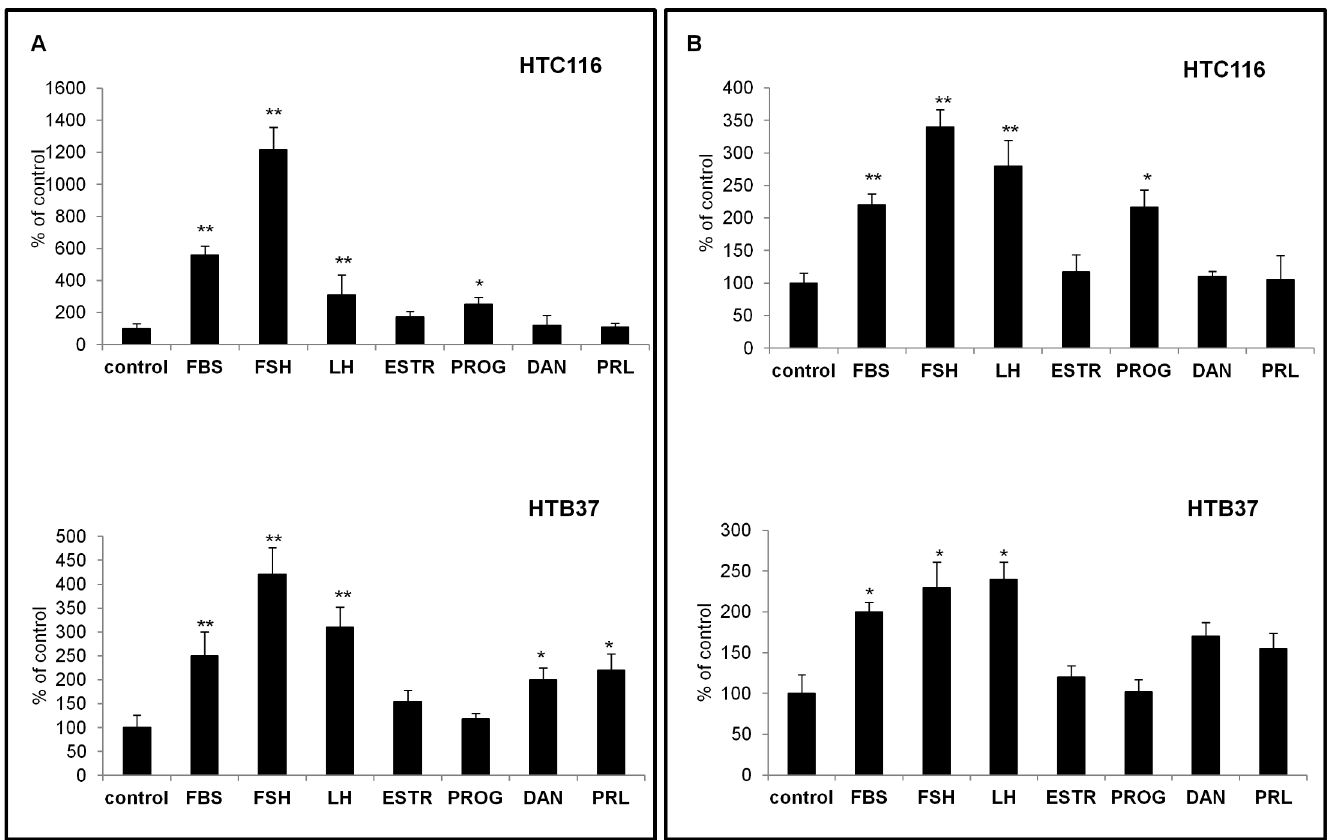
Fig 3. Effect of pituitary gonadotropins on migration and adhesion of CRC cell lines. (A) Migration of HTC116 and HTB37 cells in response to FBS (10%), follicle- stimulating hormone (FSH, 10 IU/ml), luteinizing hormone (LH, 10 IU/ml), estrogen receptor (ESTR, 100 nM), progesterone (PROG, 100 nM), danazol (DAN, 80 μ g/ ml), or prolactin (PRL, 0.5 μ g/ml). (cid:3) p (cid:20) 0.05, (cid:3)(cid:3) p (cid:20) 0,005. (B) Adhesion of HTC116 and HTB37 cells after treatment with FSH (10 IU/ml), LH (10 IU/ml), ESTR (100 nM), PROG (100 nM), DAN (80 μ g/ml), or PRL (0.5 μ g/ml) to fibronectin-coated plates. The hormones were tested in serum-free medium. Bars indicate standard deviations; (cid:3) p (cid:20) 0.05, (cid:3)(cid:3) p (cid:20) 0.005.